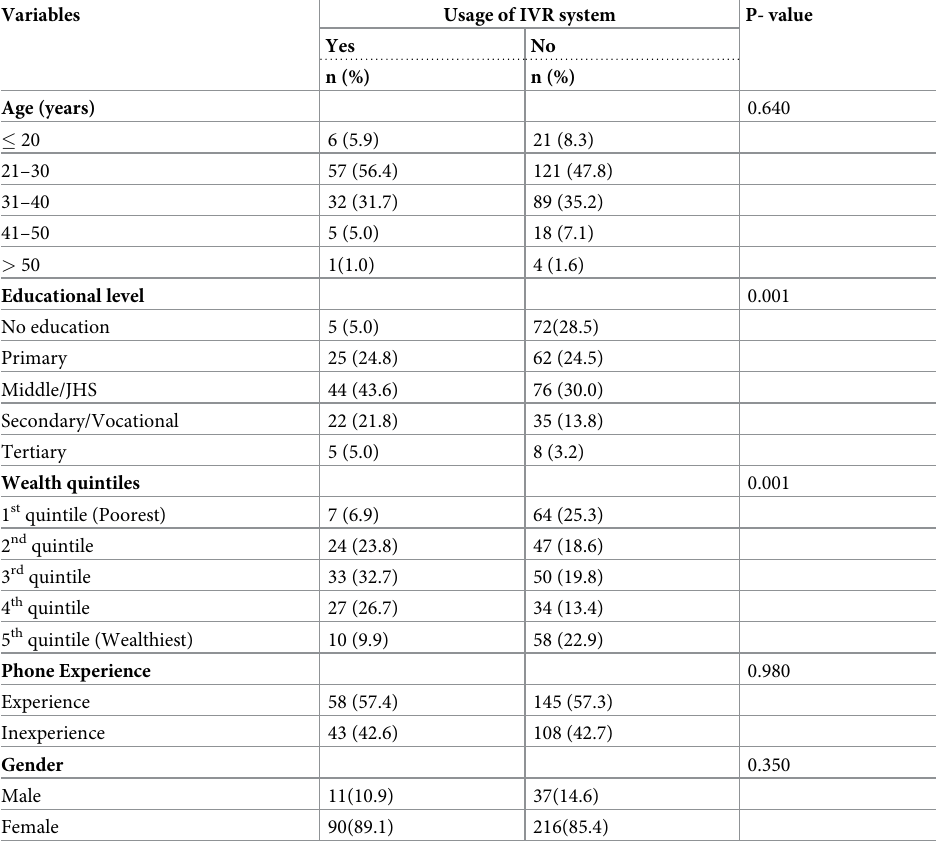
Table 3. Association between demographic characteristics and usage of the IVR system.